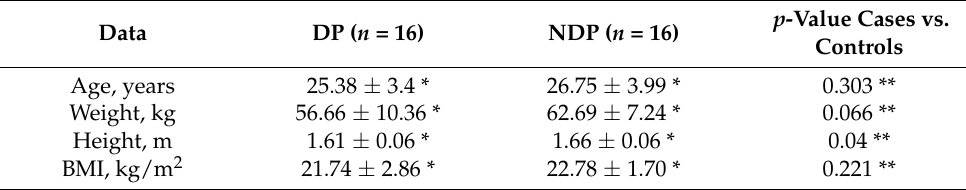
Table 1. Sociodemographic data of the sample.